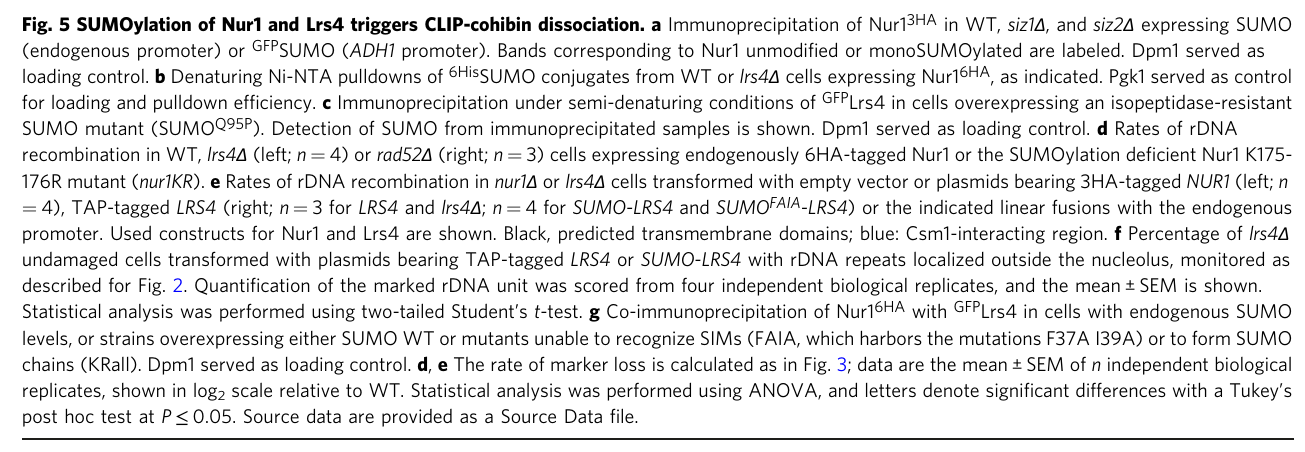
Fig. 5 SUMOylation of Nur1 and Lrs4 triggers CLIP-cohibin dissociation. a Immunoprecipitation of Nur1 3HA in WT, siz1 Δ , and siz2 Δ expressing SUMO (endogenous promoter) or GFP SUMO ( ADH1 promoter). Bands corresponding to Nur1 unmodi fi ed or monoSUMOylated are labeled. Dpm1 served as loading control. b Denaturing Ni-NTA pulldowns of 6His SUMO conjugates from WT or lrs4 Δ cells expressing Nur1 6HA , as indicated. Pgk1 served as control for loading and pulldown ef fi ciency. c Immunoprecipitation under semi-denaturing conditions of GFP Lrs4 in cells overexpressing an isopeptidase-resistant SUMO mutant (SUMO Q95P ). Detection of SUMO from immunoprecipitated samples is shown. Dpm1 served as loading control. d Rates of rDNA recombination in WT, lrs4 Δ (left; n = 4) or rad52 Δ (right; n = 3) cells expressing endogenously 6HA-tagged Nur1 or the SUMOylation de fi cient Nur1 K175- 176R mutant ( nur1KR ). e Rates of rDNA recombination in nur1 Δ or lrs4 Δ cells transformed with empty vector or plasmids bearing 3HA-tagged NUR1 (left; n = 4), TAP-tagged LRS4 (right; n = 3 for LRS4 and lrs4 Δ ; n = 4 for SUMO-LRS4 and SUMO FAIA -LRS4 ) or the indicated linear fusions with the